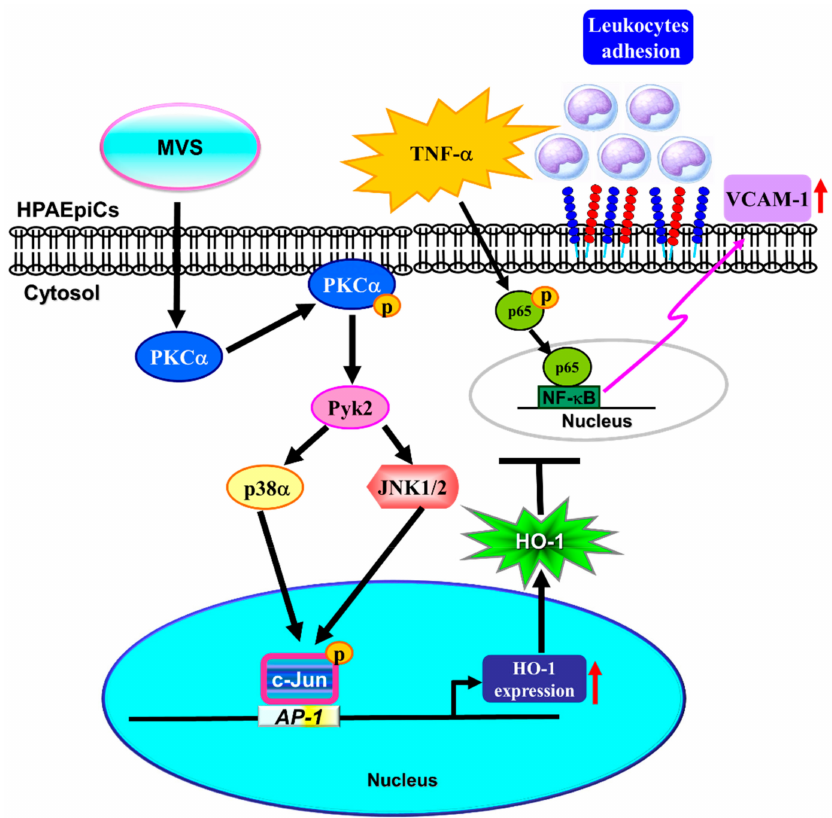
Figure 7. A schematic pathway for MVS-induced HO-1 expression protecting against the inflammatory responses in HPAEpiCs challenged with TNF α . MVS-induced HO-1 expression was mediated via PKC α / Pyk2 / p38 MAPK or JNK1 / 2-dependent phosphorylation of c-Jun binding to AP-1 binding sites